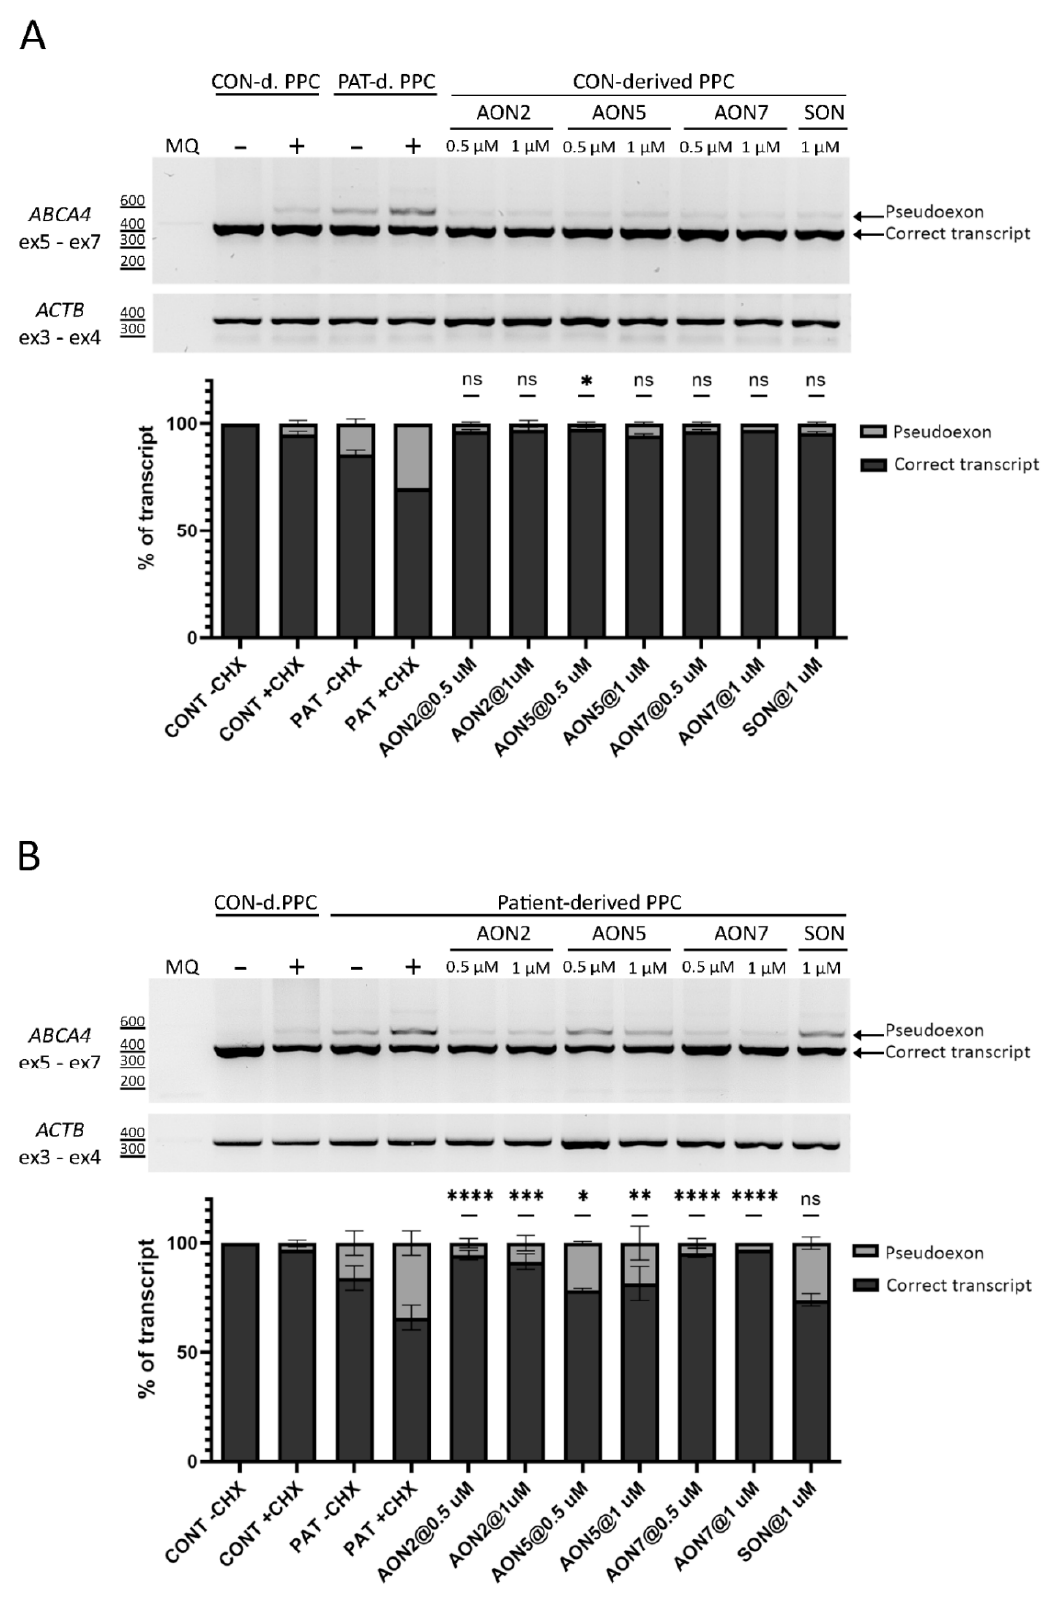
Figure 3. AON-based rescue for the deep-intronic c.769-784C>T variant in PPCs. Analysis of splicing correction by RT-PCR upon AON delivery to control and patient-derived PPCs. Three AONs were delivered naked to control ( A ) and patient-derived ( B ) PPCs at 0.5 µ M and 1 µ M concentrations. SON was delivered at 1 µ M only. Cells were cultured in the absence ( − ) or presence (+) of CHX. The